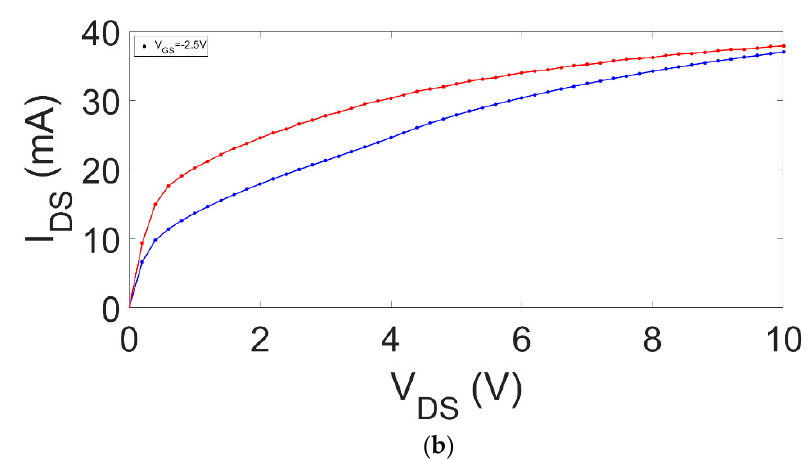
Figure 5. I DS versus V DS for V GS = − 2.5 V measured for ( a ) the 100 µm HEMT and ( b ) the 200 µm HEMT without (blue line) and with (red line) laser exposure.